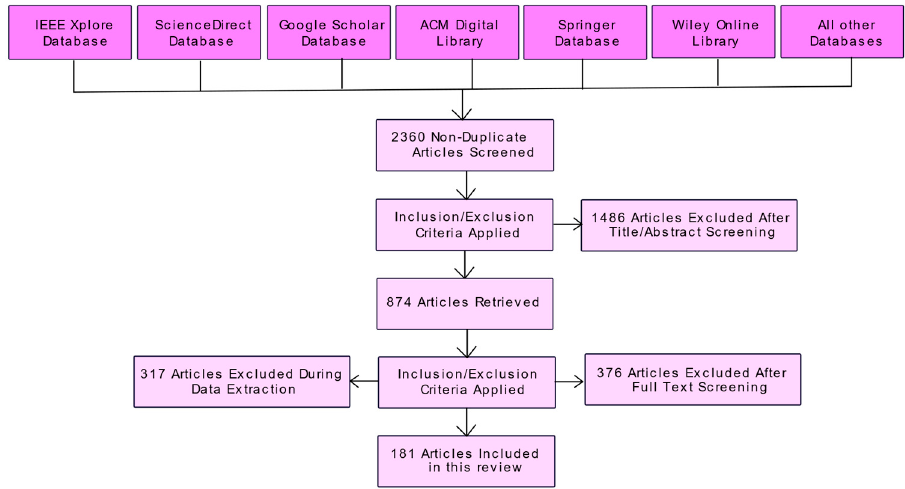
Figure 2. PRISMA flow diagram for the selection process of the research articles used in this review. The 181 articles studied in this research from 2009 to 2020 are depicted in Figure 3.